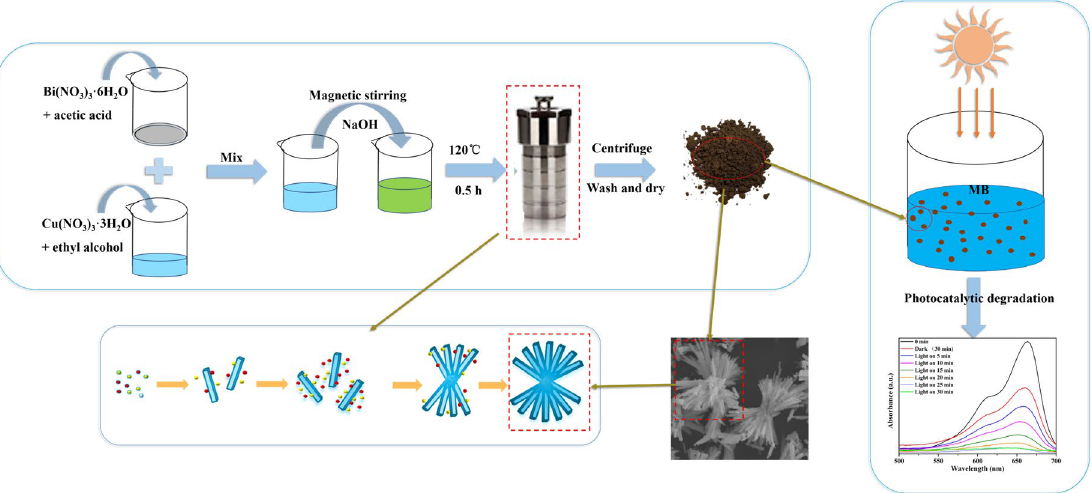
Figure 4. Preparation of CuBi 2 O 4 by hydrothermal method, morphology of CuBi 2 O 4 under different hydrothermal time, and UV-vis diffuse reflectance spectrum of CuBi 2 O 4 under different hydrothermal times. Reprinted with permission from [35] © 2020 MDPI.